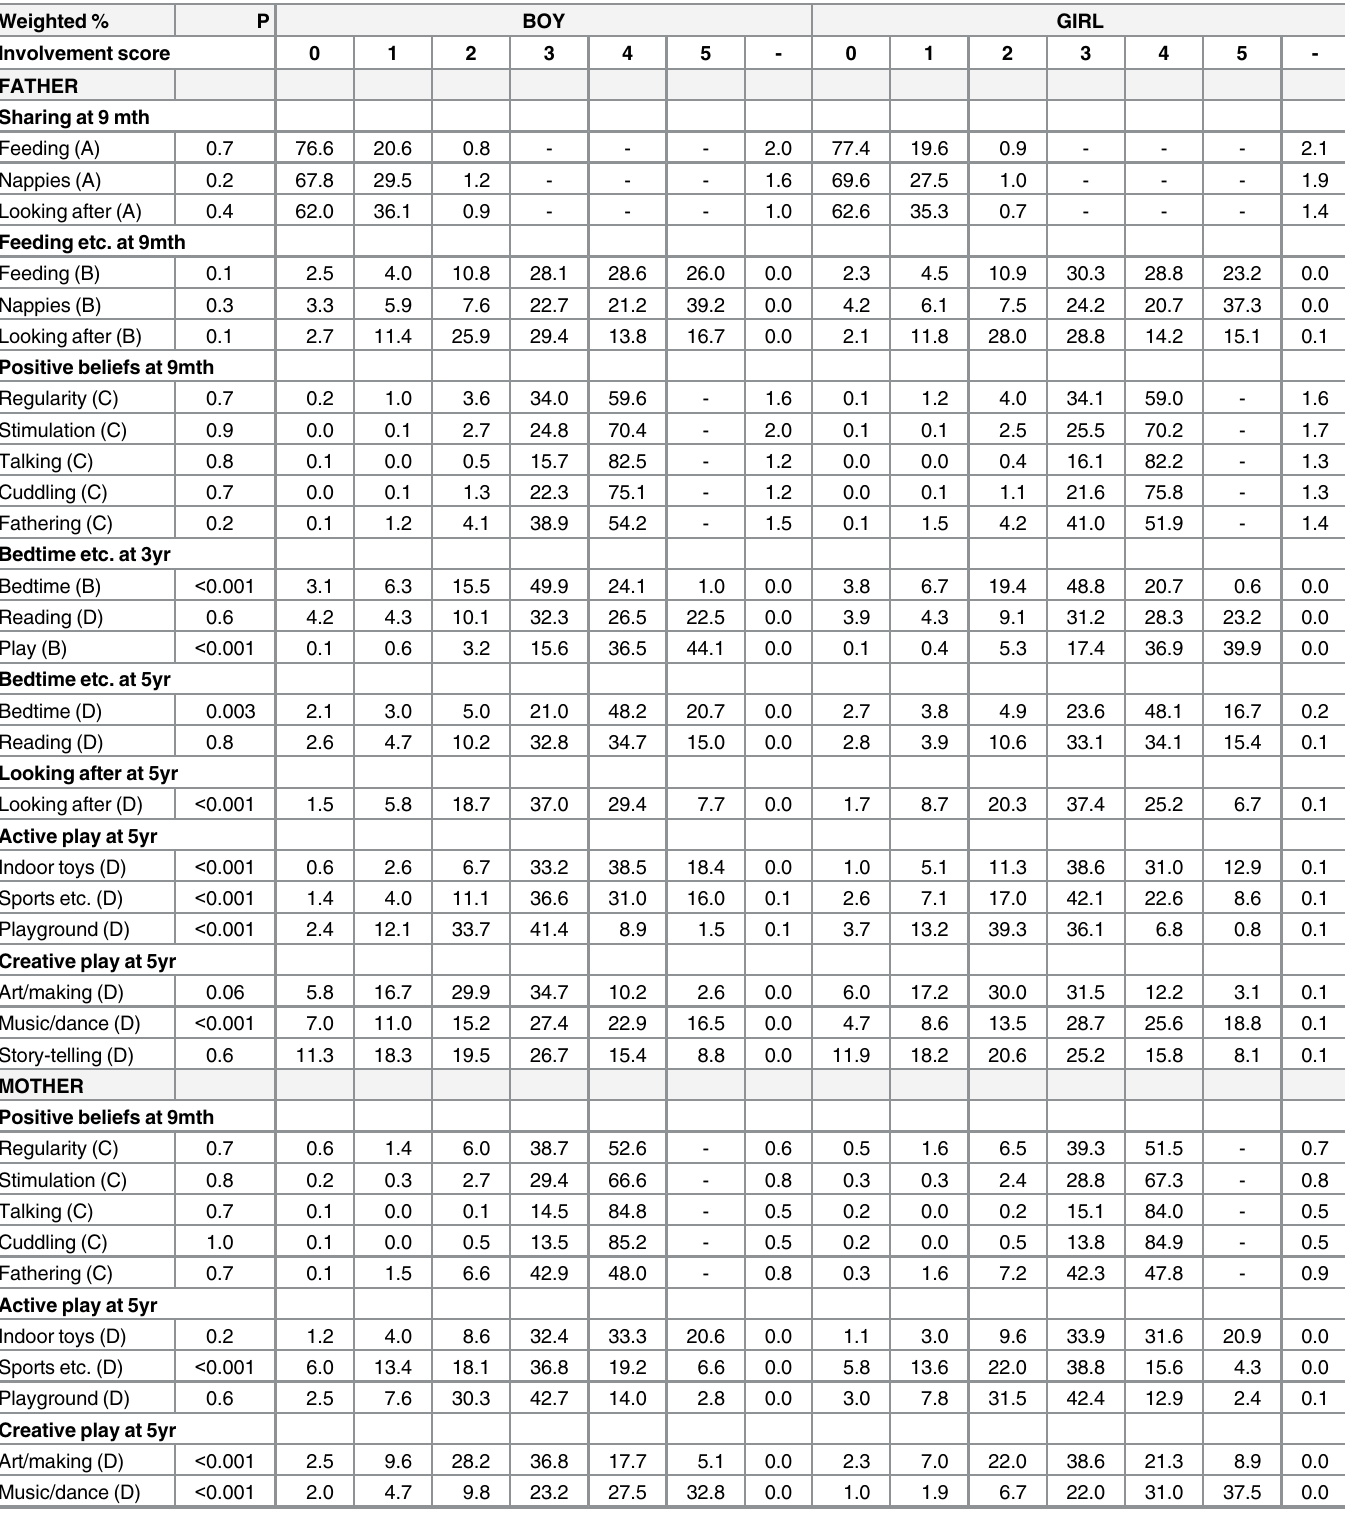
Table 2. Distributions of parent involvement